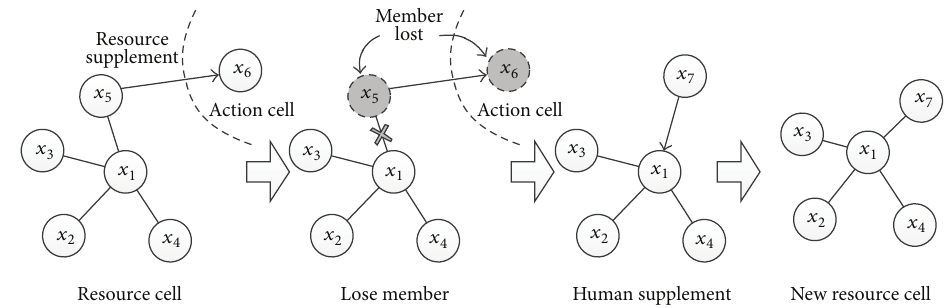
Figure 6: The recovery mechanism of resource